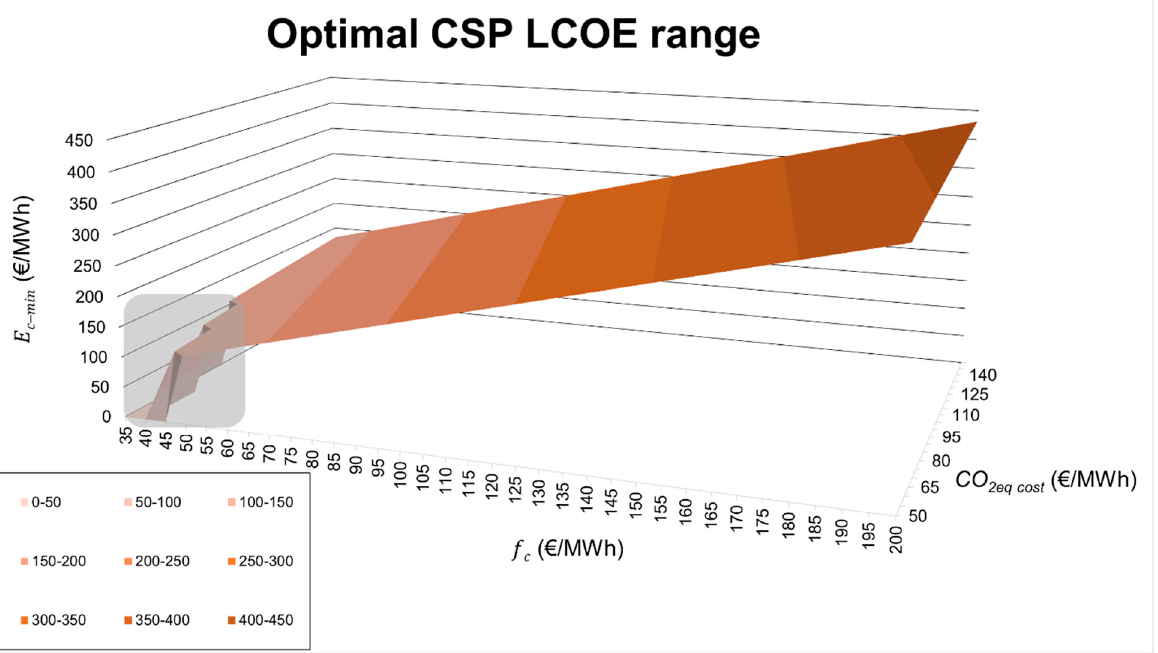
Figure 17. LCOE for CSP plants with competitive cost range.